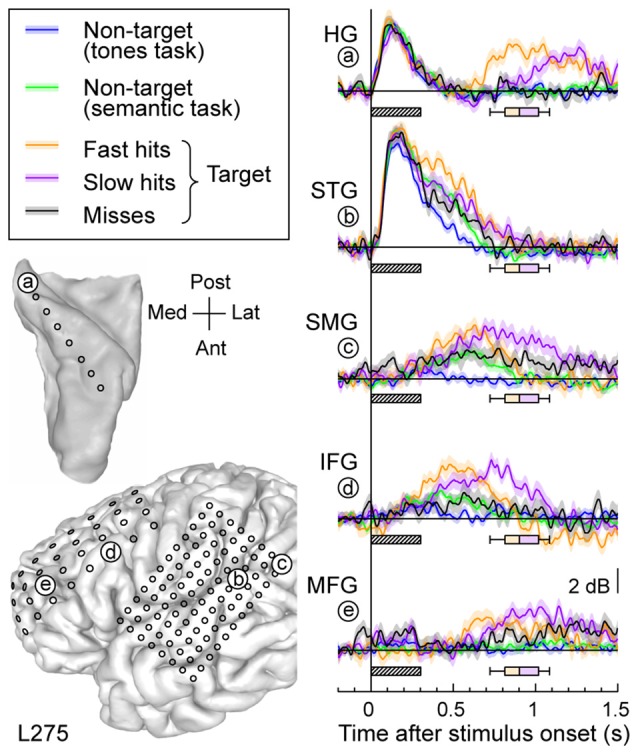
Relative timing of high gamma responses across task and target conditions and brain regions. Representative data from subject L275. Left column, top: MRI reconstruction of the top-down view of left superior temporal plane depicting the location of the electrode trajectory and representative recording site in posteromedial HG (site “a”). Left column, bottom: MRI reconstruction of the lateral view of the left cerebral hemisphere depicting the electrode coverage and location of the representative recording sites in STG, SMG, IFG and MFG (sites “b” through “e”, respectively). Right column: average high gamma waveforms recorded for the five exemplary sites (“a” through “e”). Responses were averaged across trials when words were non-targets in a tone detection task (blue), non-targets in a semantic categorization task (green) and targets in a semantic categorization tasks. For the latter condition, responses were plotted separately for trials that were associated with fast behavioral responses (orange), slow responses (purple) and misses (black). Lines and shaded areas represent mean high gamma ERBP and its standard error. Shaded boxes underneath high gamma waveforms represent stimulus duration (300 ms); box-and-whiskers plots denote the timing of button presses to the target stimuli (median, 10th, 25th, 75th and 90th percentile).